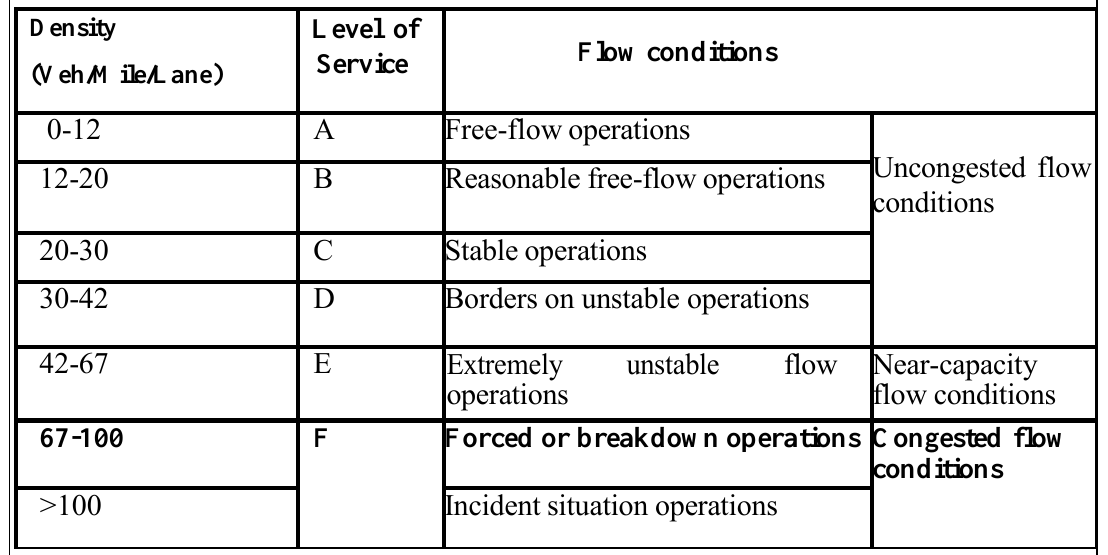
Table 1. Traffic flow state for different densities